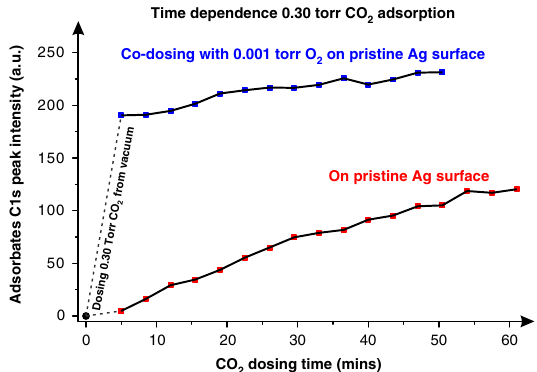
Fig. 3 The C 1 s signal of surface adsorbate increase as a function of CO 2 dosing time. The adsorbate signals for 0.3 Torr CO 2 adsorption alone and in the presence of 0.001 Torr O 2 were recorded at an increased dosing time, shown as red and blue points, respectively. A black line across the data point is used for the eye guidance. The peak intensity is the raw intensity without considering the signal decay due to introducing